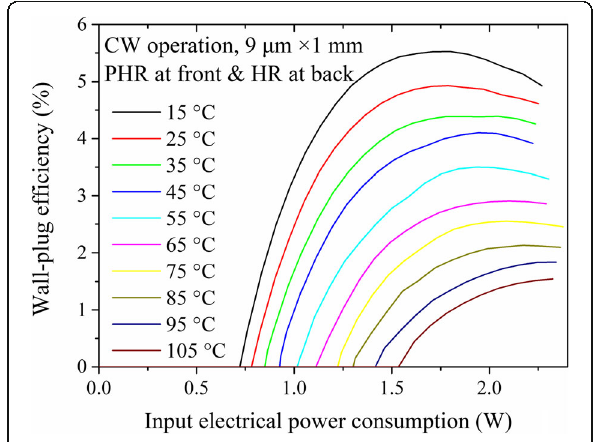
Fig. 5 Wall-plug efficiency as a function of the electrical power dissipation for the 1-mm-long PHR and HR-coated DFB